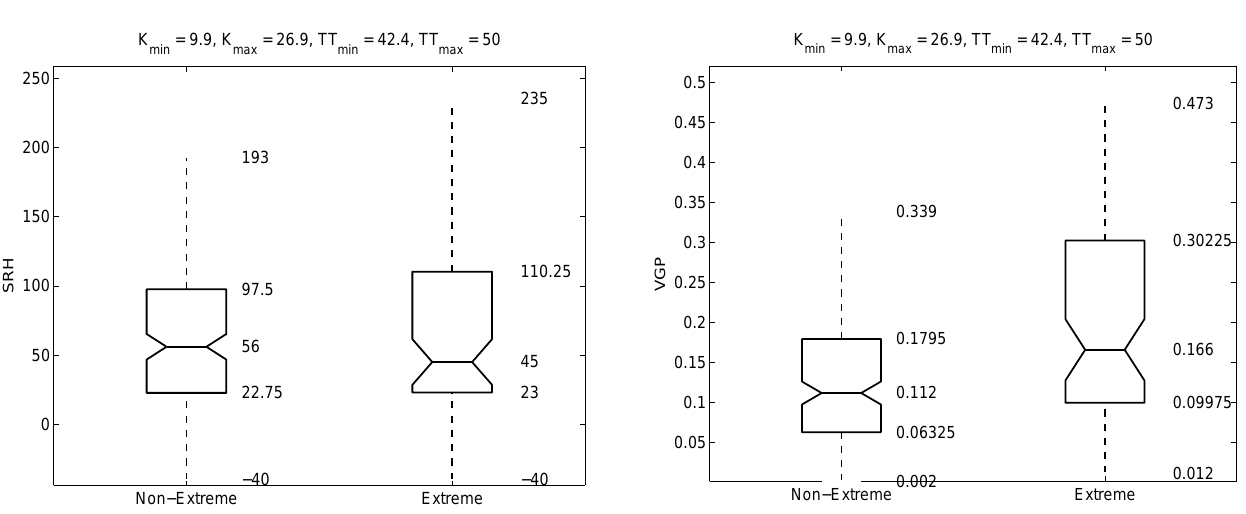
Fig. 5. The distribution of the values of the BRN index for the days Fig. 6. The distribution of the values of the BRNsh index for the where extreme (right) and non-extreme (left) events occurred. days where extreme (right) and non-extreme (left) events occurred.